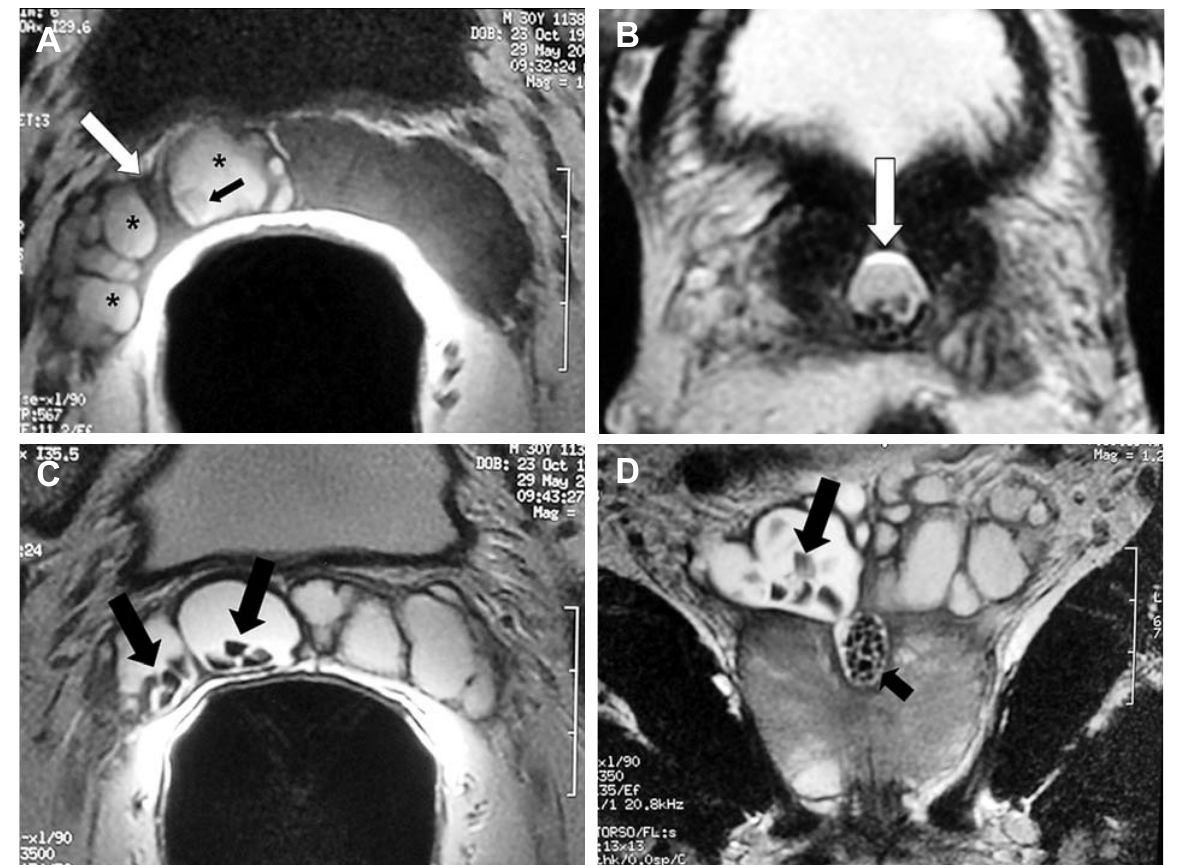
Figure 3 – Hemorrhagic seminal vesicle associated with calculi within the right seminal vesicle and dilated ejaculatory duct. A 30- year-old man, with history of persistent hemospermia and ejaculatory pain. A) E-MRI, axial plane, T1-weighted image, showing a hemorrhagic dilated ejaculatory duct (white arrow), containing blood (asterisk) and calculi (black arrow). B) E-MRI, axial,T2-weighted image ,better shows the calculi within the dilated ejaculatory duct (arrow). C) and D) E-MRI, axial and coronal T2-weighted images respectively, nicely demonstrates the presence of several stones within the right seminal vesicle (arrows) and within the dilated right ejaculatory duct (small arrow). Note the contiguity of the dilated seminal vesicle with the dilated right ejaculatory duct. This is an